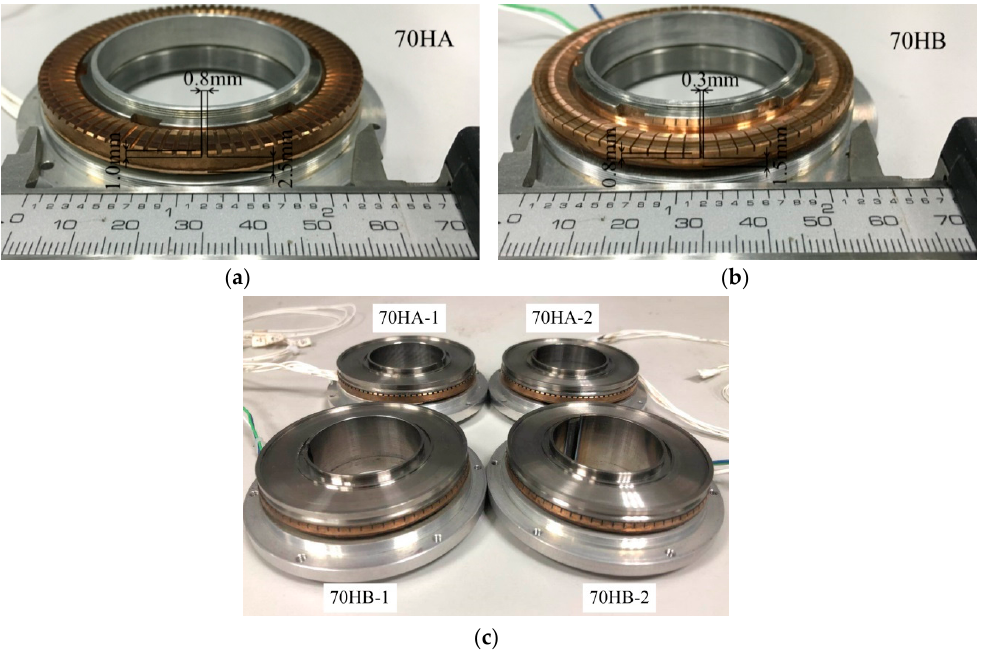
Figure 11. Comparison of stators and motors: ( a ) stator of 70HA; ( b ) stator of 70HB; and ( c ) two sets of prototype motors.